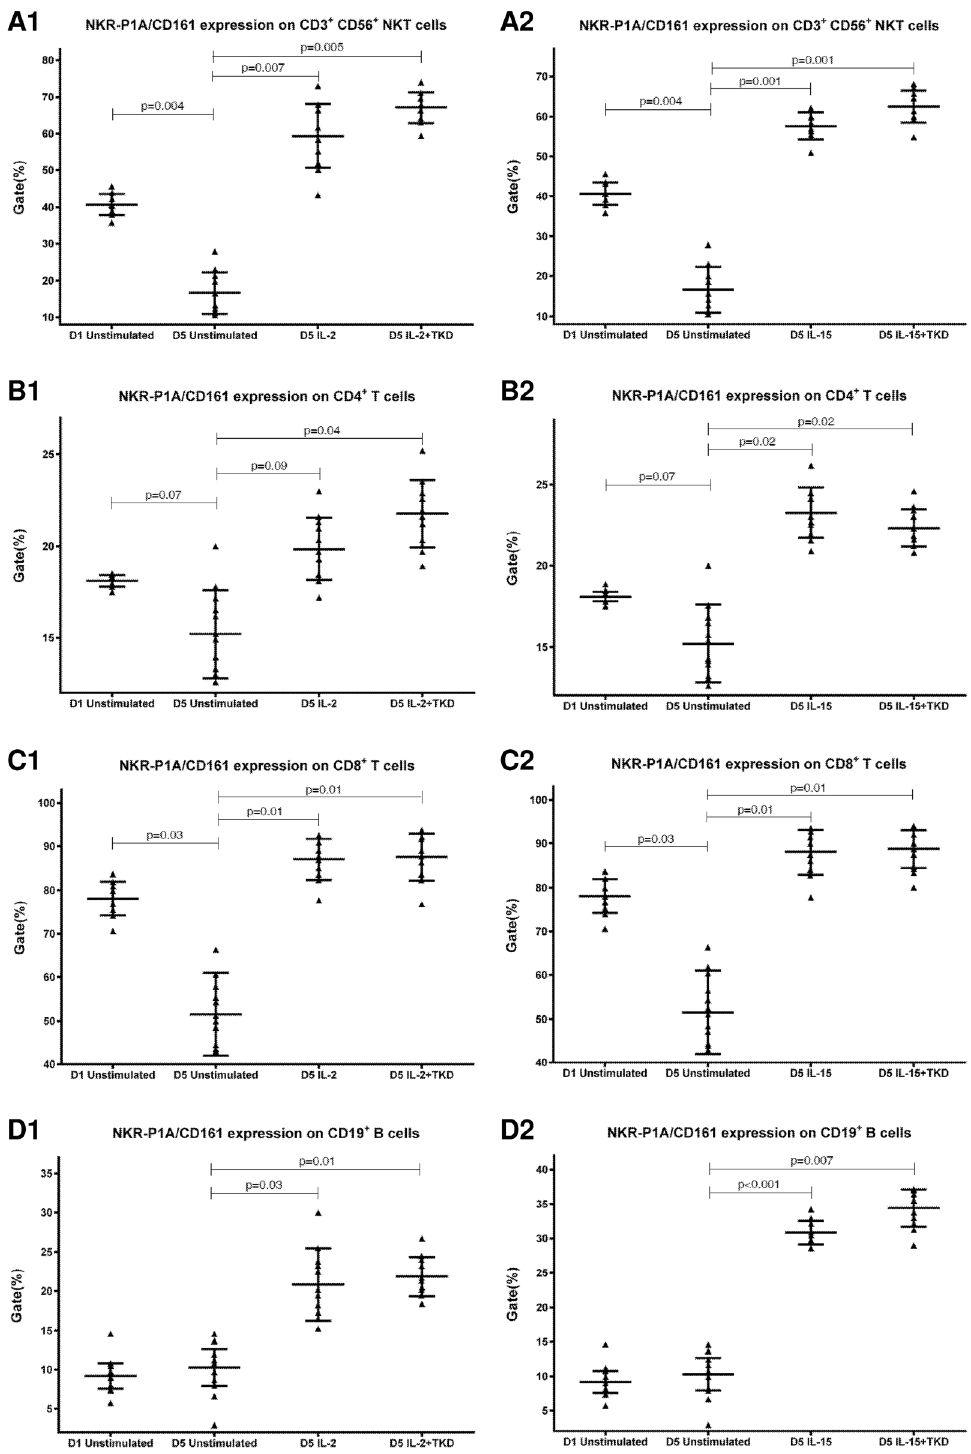
Fig 4. The effect of IL-2, IL-15, IL-2/TKD and IL-15/TKD on the expression of NKR-P1A receptor in peripheral blood mononuclear cells of healthy individuals — the proportion of CD3 + CD56 + NKT cells, CD4 + T cells, CD8 + T cells and CD19 + B cells expressing an appropriate receptor. The expression of NKR-P1A receptor on CD3 + CD56 + NKT cells, CD4 + T cells, CD8 + T cells and CD19 + B cells was examined within the fraction of unstimulated and stimulated mononuclear cells derived from 10 healthy individuals. Data are presented as means ± standard error. In total, the study cohort consisted of 52 Caucasian healthy